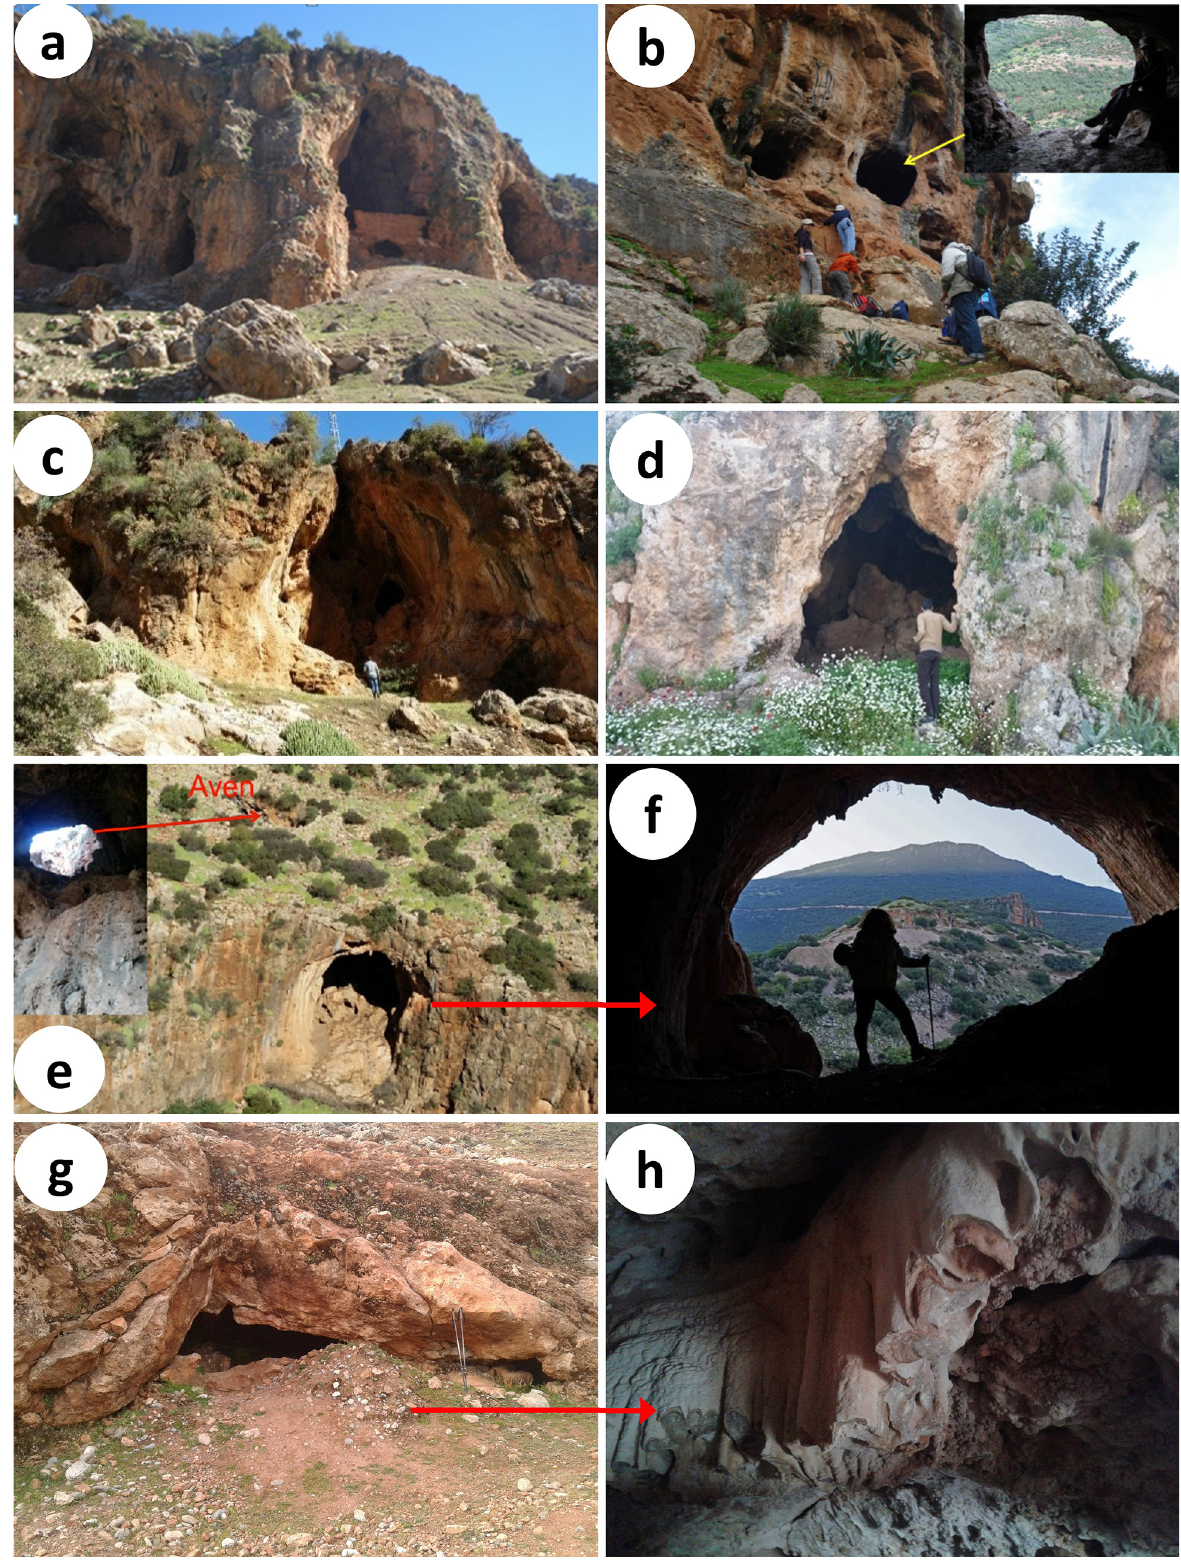
Fig. 10. The different caves encountered in the study area. (a) Caves of the cliffs of Timoulilte. (b) Caves of the cliffs of Tit n’ziza at dir d’El Ksiba. (c) Cave of the cliffs of Tanougha. (c) Cave of Tazart n’amar at Tanougha. (e) Cave of Foum El Ancer. (f) View from inside Foum El Ancer cave. (g) Cave of Orbiaa site. (h) Stalactites inside Orbiaa